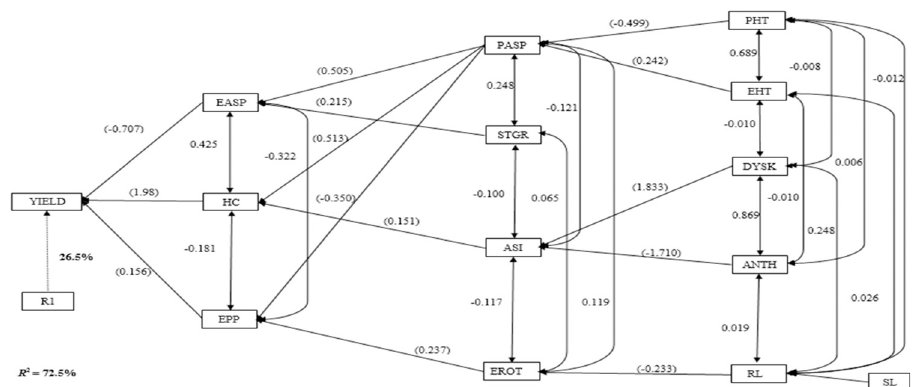
Fig 3. Path analysis model diagram showing causal relationships of measured traits of extra-early maturing provitamin A maize hybrids evaluated under low-N environments in Ile-Ife and Mokwa. R 2 = co-efficient of determination; R1 = residual effects; YIELD = grain yield; EASP = ear aspect; EPP = ears per plant; ANTH = days to 50% anthesis; SL = stalk lodging; ASI = anthesis–silking interval; PASP = plant aspect; DYSK = days to 50% silking; STGR = stay green characteristics; PHT = plant height; EHT = ear height; HC = husk cover; RL = root lodging; EROT = ear rot.